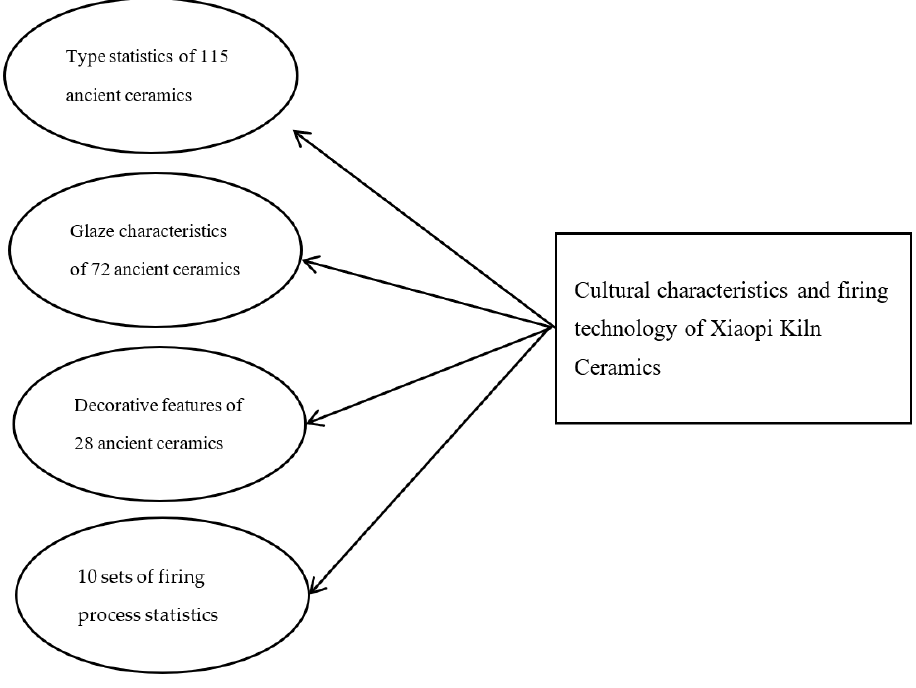
Figure 1. Research model.